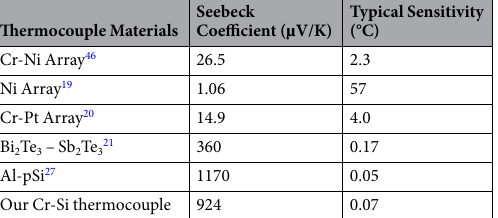
Table 1. List of recently reported thin-film thermocouples and their corresponding Seebeck coefficients. Typical sensitivities were calculated assuming a minimum voltage-detection level of 60 µ